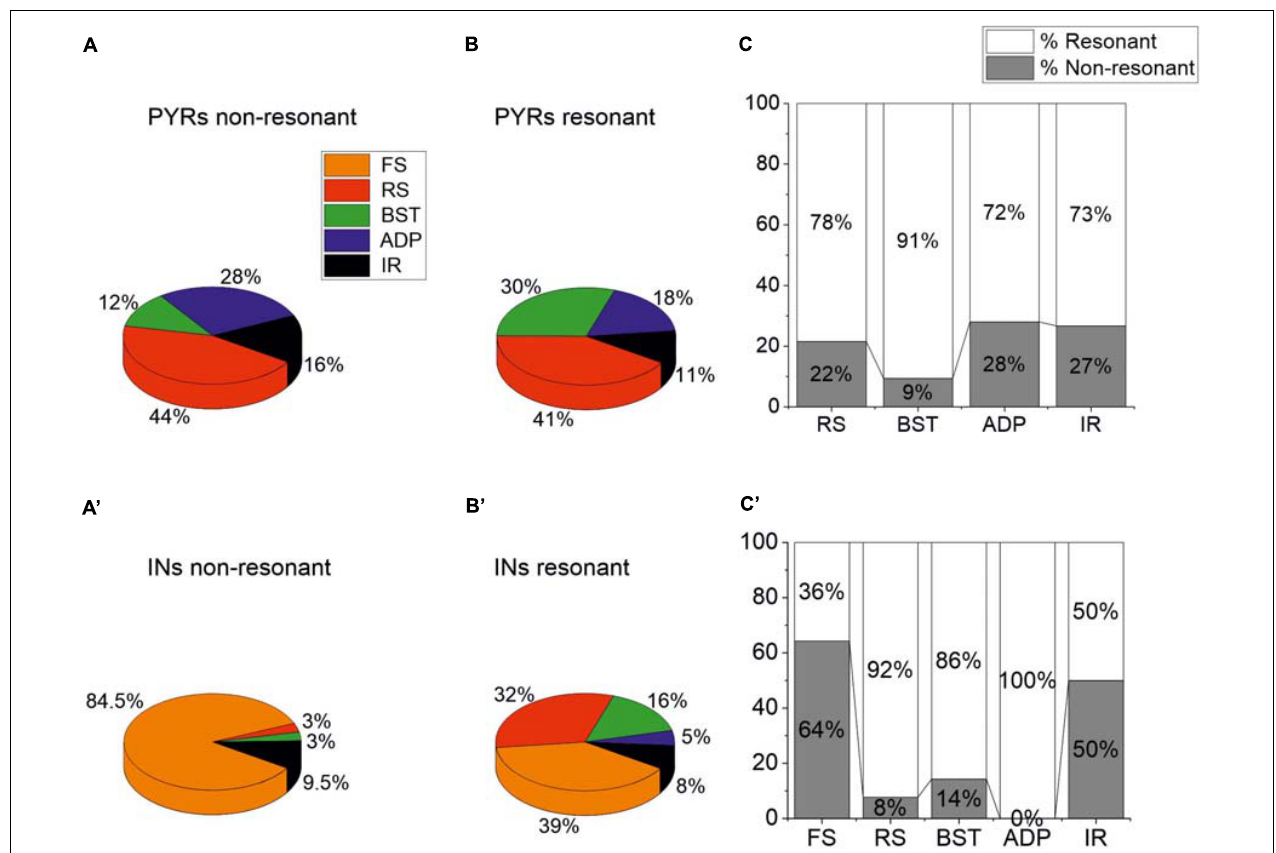
FIGURE 4 | Relationships between firing patterns and resonant or non-resonant behavior of the PRC neurons. (A,B) Percentage of specific firing patterns for resonant (A) and non-resonant (B) PRC pyramidal neurons. (C) Percentage of resonant vs. non-resonant cells classified for a specific firing pattern of pyramidal neurons. (A (cid:48) –C (cid:48) ) Same as (A–C) for GABAergic